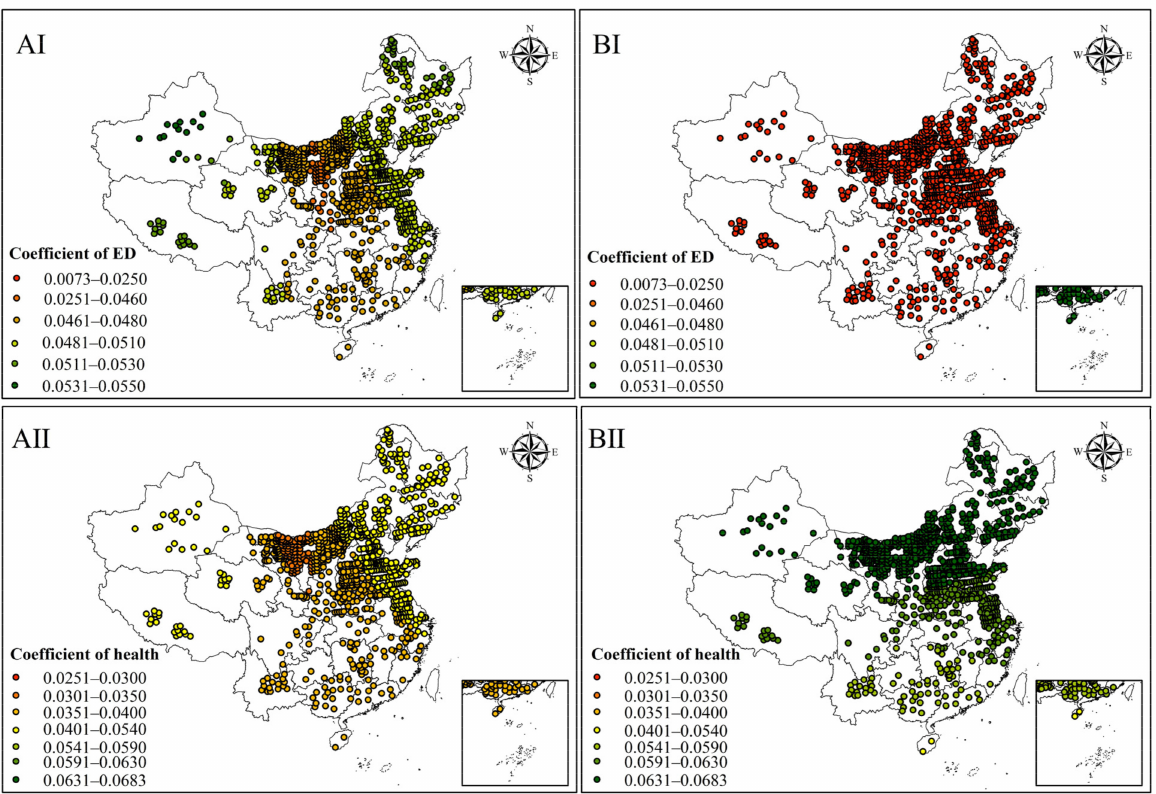
Figure 7. The effects of environmental quality ( above ) and environmental effects on health ( below ) in describing WTPEP before ( left ) and during ( right ) COVID-19 based on MGWR